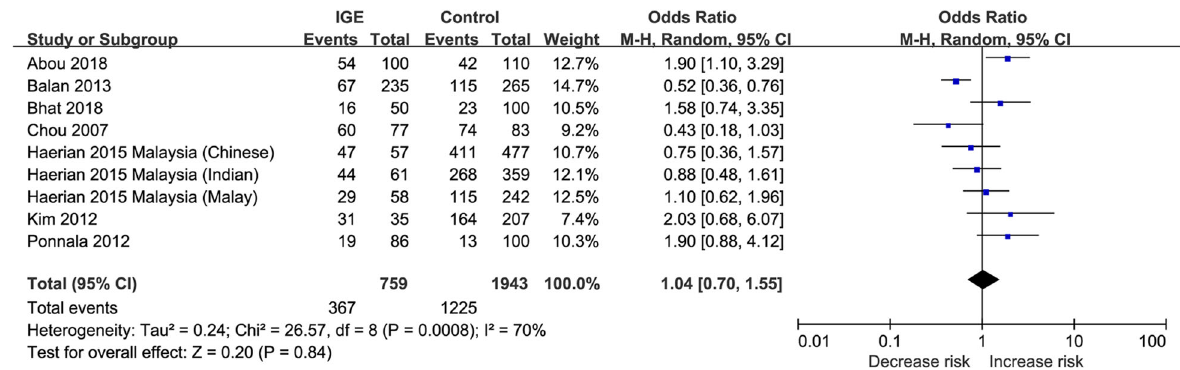
Fig. 3 Forest plot for subgroup analysis of Asian participants. No significant relationship was found between the GABRG2 rs211037polymorphism and susceptibility to IGE in Asian participants